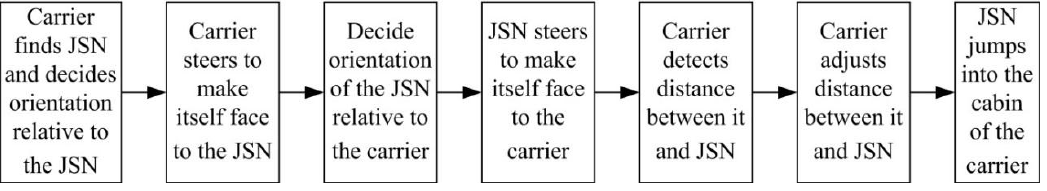
Figure 2. Working procedure of the jumping sensor node (JSN)